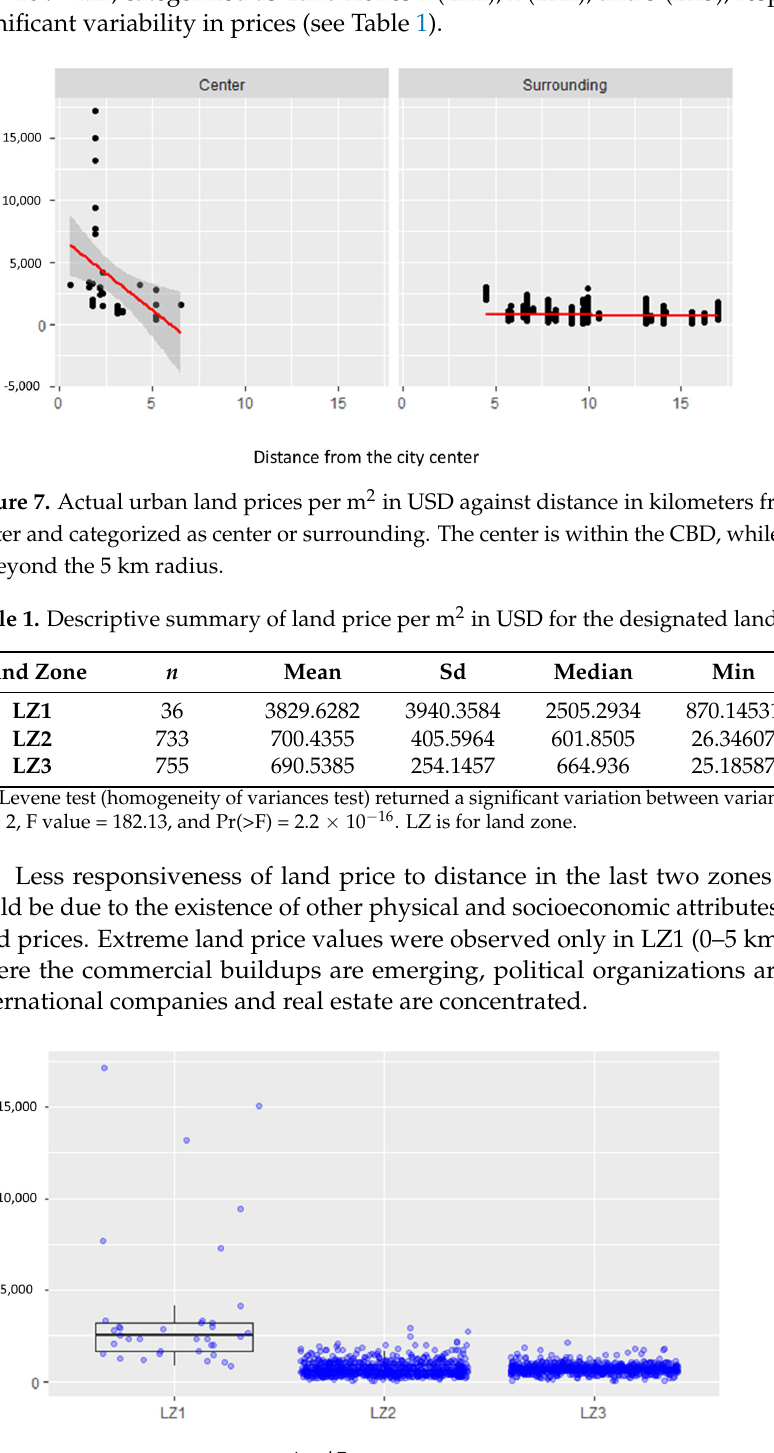
center and is characterized by a consistent value beyond the indicated distance (Figure 7).